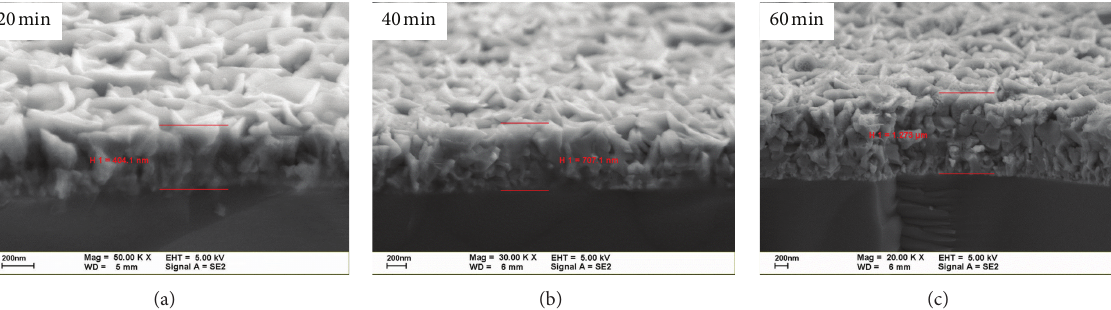
Figure 1: FESEM micrographs of the ZnO:YAG films (YAG phosphor at 5wt%) with various deposition times: (a) 20 min, (b) 40 min, and (c) 60 min.